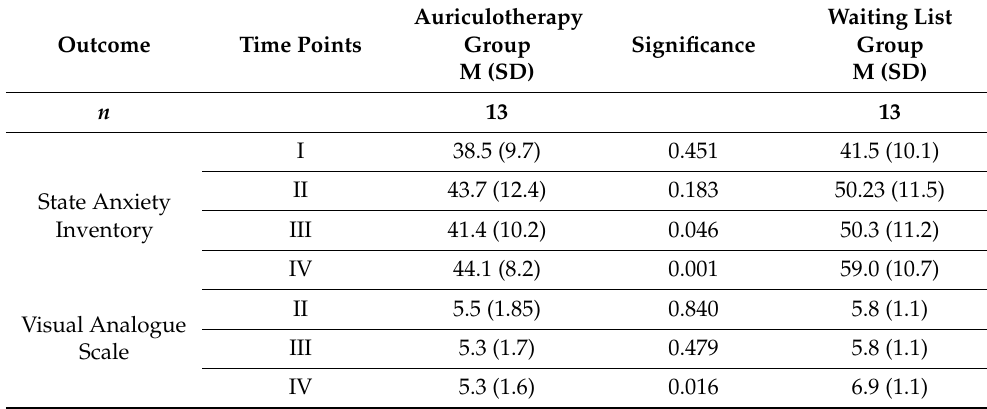
Table 2. Outcome of the investigation data by independent samples t -test given as mean ± standard deviations of anxiety levels measured by the Staite Anxiety Inventory Visual Analogue